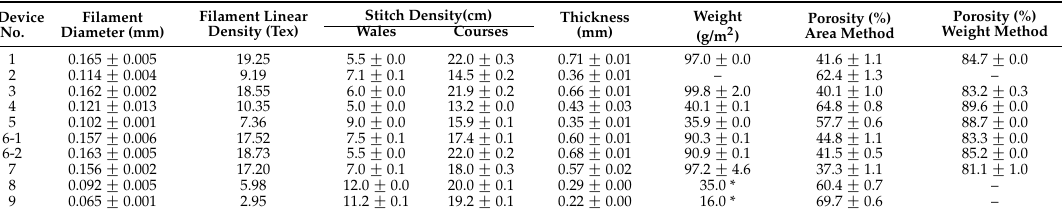
Table 1. Textile structures and physical characteristics of fabrics. Device